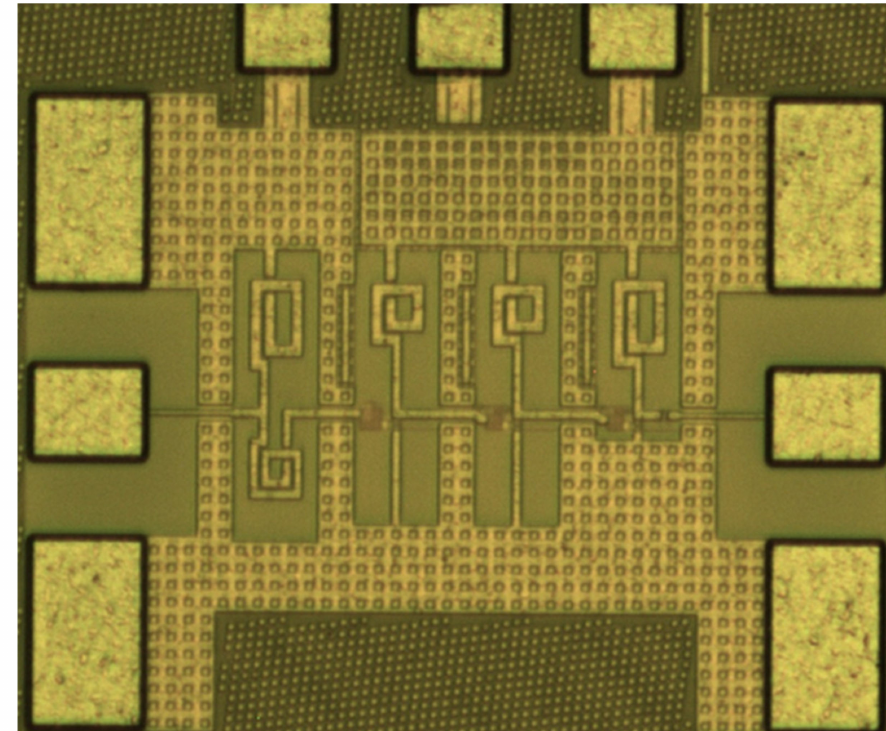
Figure 8. Chip microphotograph of 60 GHz CMOS LNA test pattern.